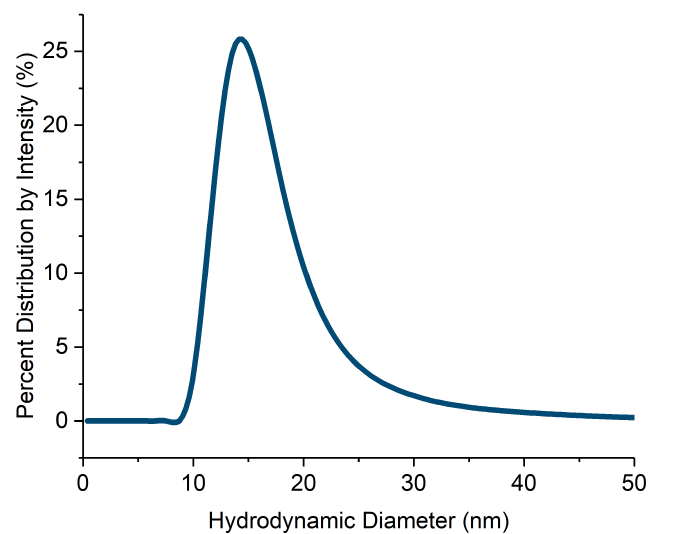
Figure A1. Hydrodynamic size distribution of ‘small’ nanoparticles used in study. D h = 16 ± 1